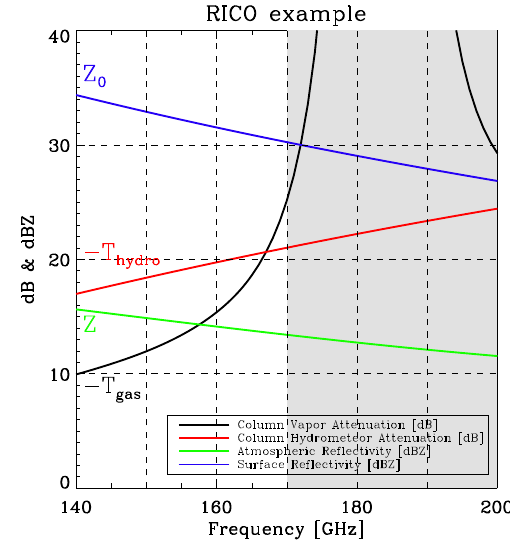
Figure 4. An example of the spectral variation of the column two- way attenuation due to water vapor, the two-way attenuation due to hydrometeors, the surface reflectivity assuming a range resolution of 240m, and the hydrometeor reflectivity. This example is from a single precipitating column in the RICO simulation. The gray shaded frequencies are not examined in this work because of the large attenuation due to vapor near the absorption